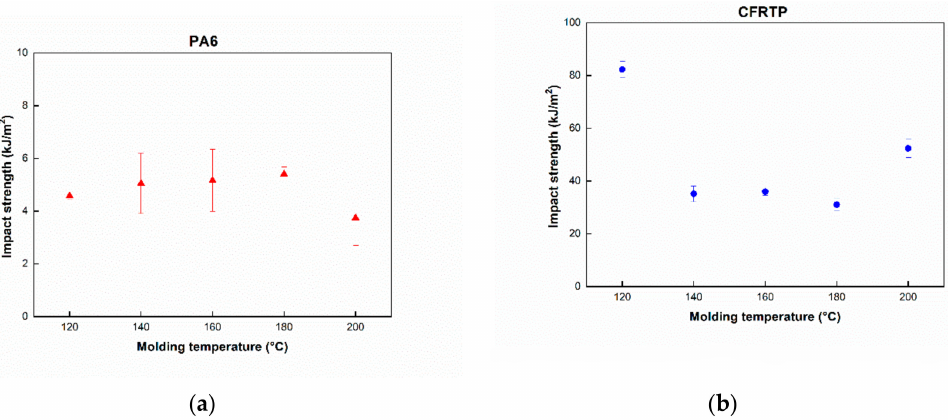
Figure 6. Impact strength at di ff erent molding temperatures. ( a ) PA6, ( b )